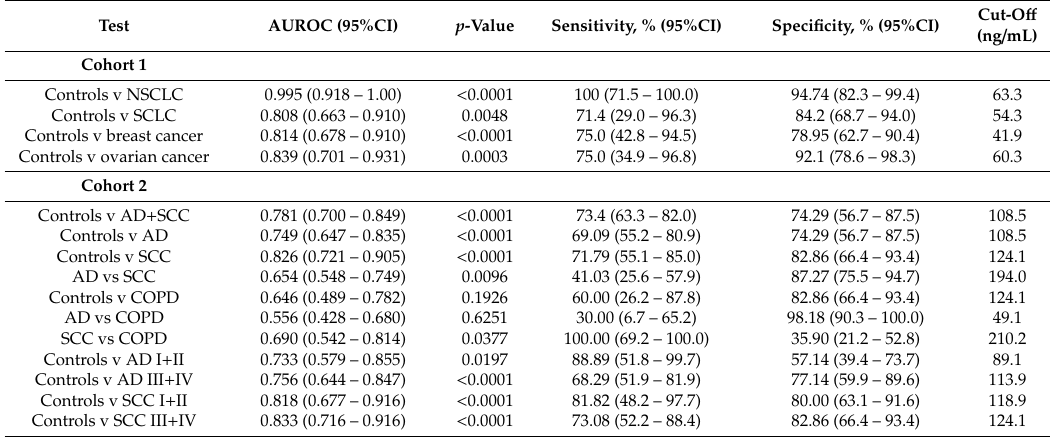
Table 3. Summary of AUROC tests.